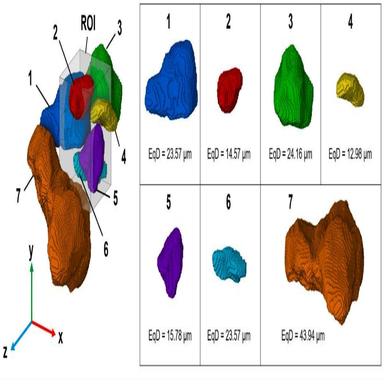
3D visualization of loess microstructure based on images from μXCT and FIB-SEM. (a) Seven silt-sized skeleton particles extracted from μXCT as numbered from 1 to 7, with the individual view and equivalent diameter of each particle listed aside. (b) and (c) The seven skeleton particles included in the ROI extracted from μXCT and FIB-SEM respectively. (d) FIB-SEM results displaying additional particles and fine clays that are not resolved by μXCT.